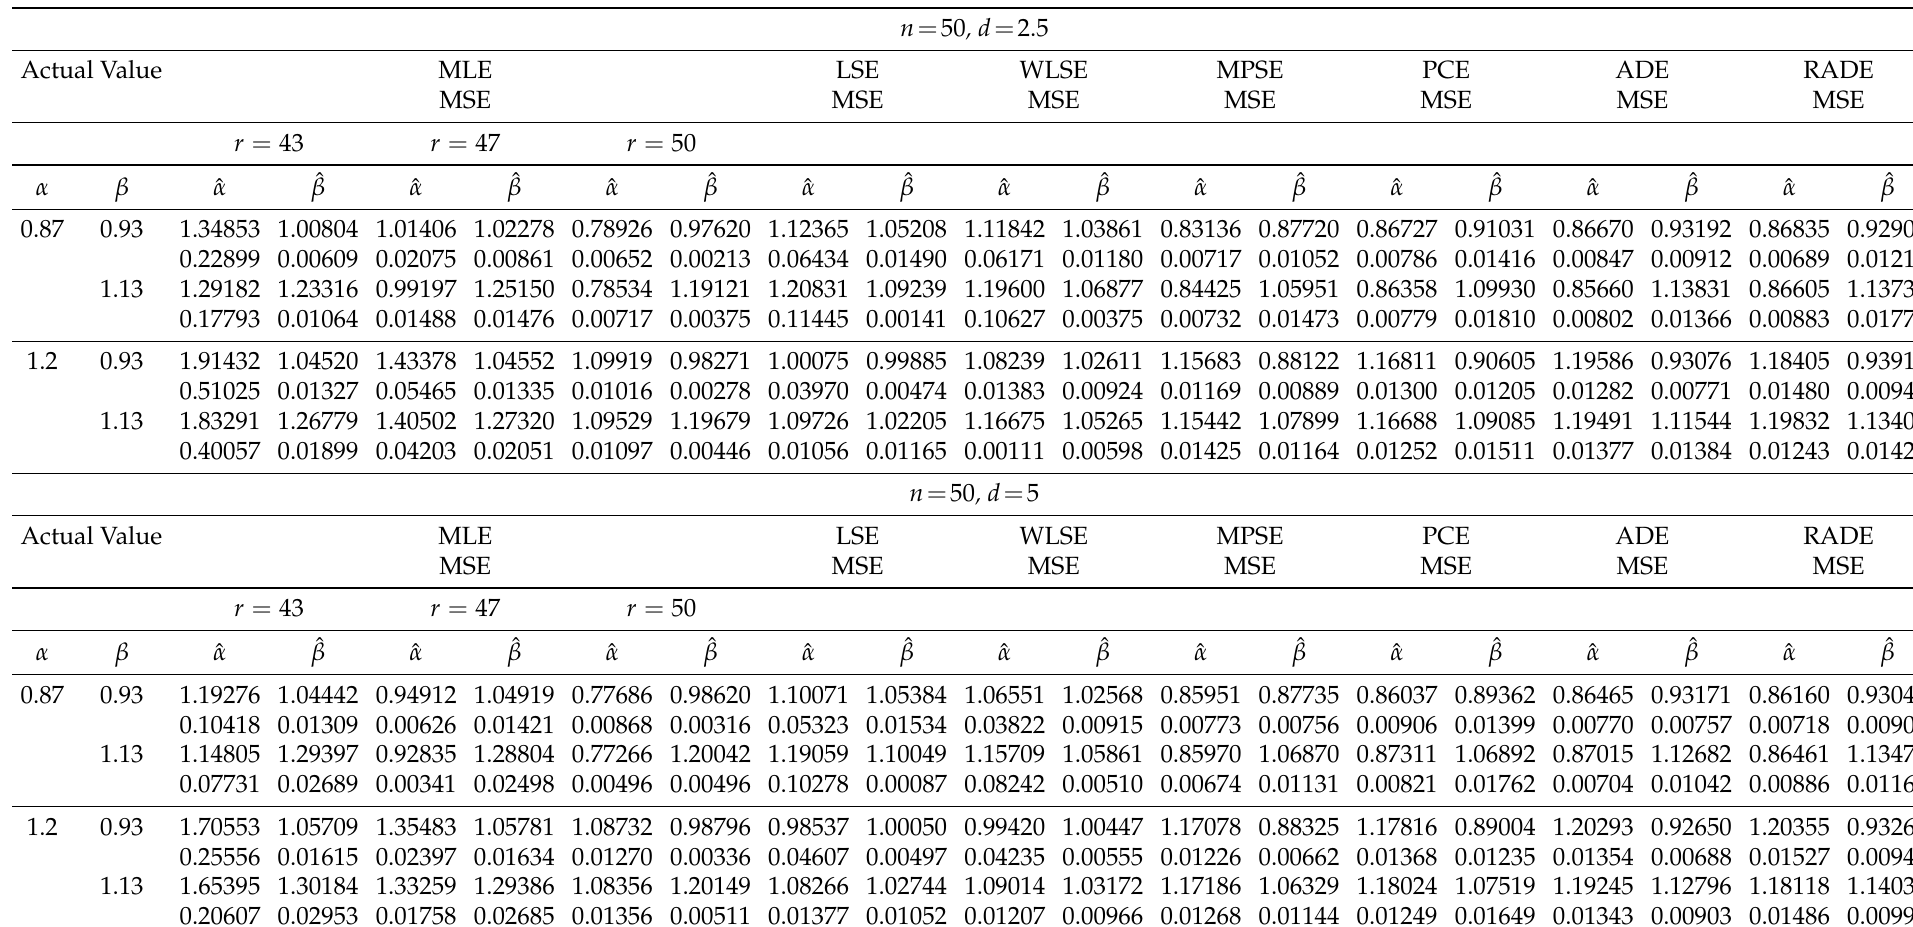
Table 4. The MLEs, LSEs, WLSEs, MPSEs, PCEs, ADEs, RADEs and their